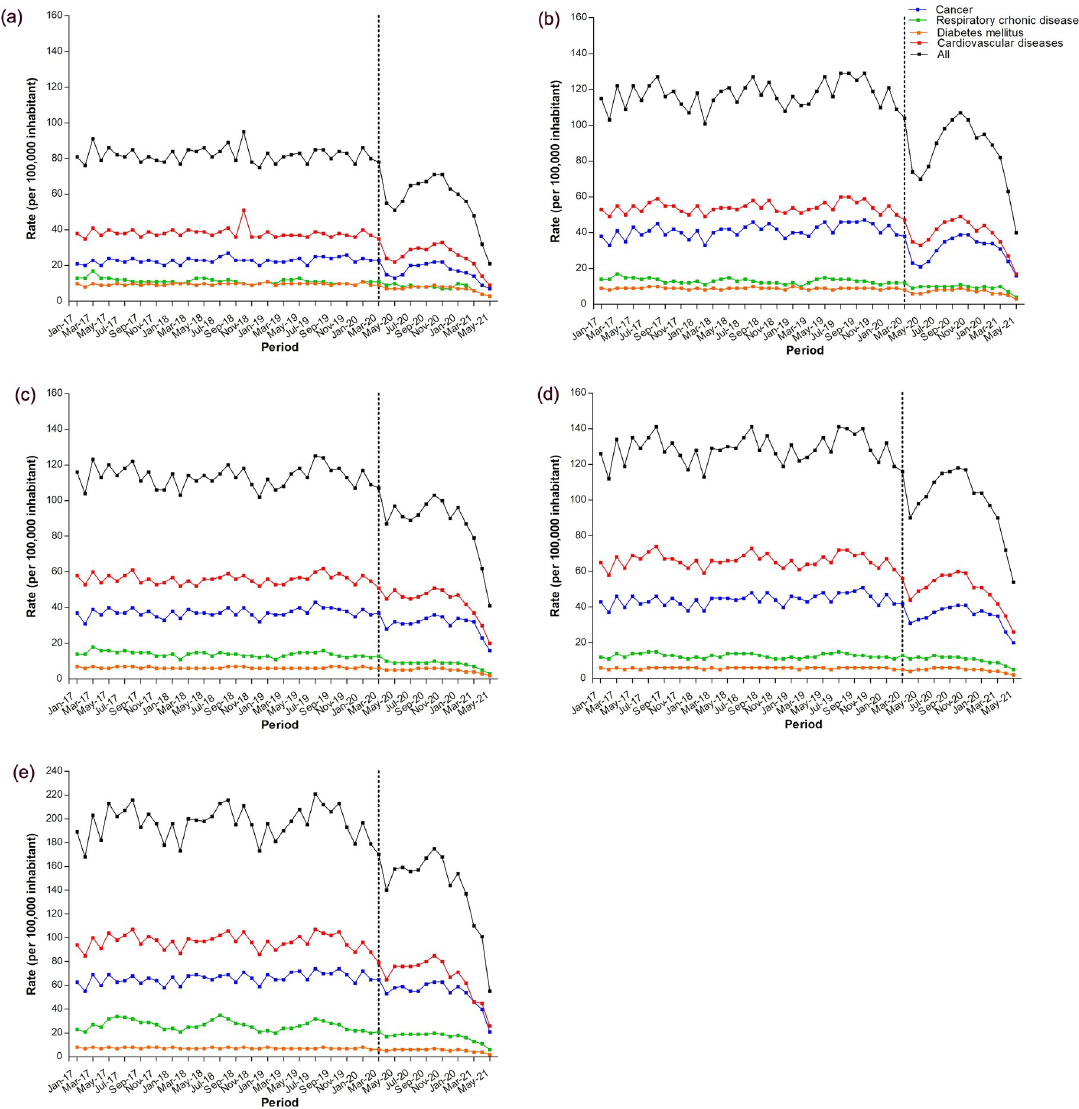
Fig 4. Hospital admission rate for chronic non-communicable diseases (NCDs) in Brazil according to the type of NCD and region of Brazil: (a) North, (b) Northeast, (c) Midwest, (d) Southeast, and (e) South. Pre-pandemic period: January 1, 2017 to February 29,